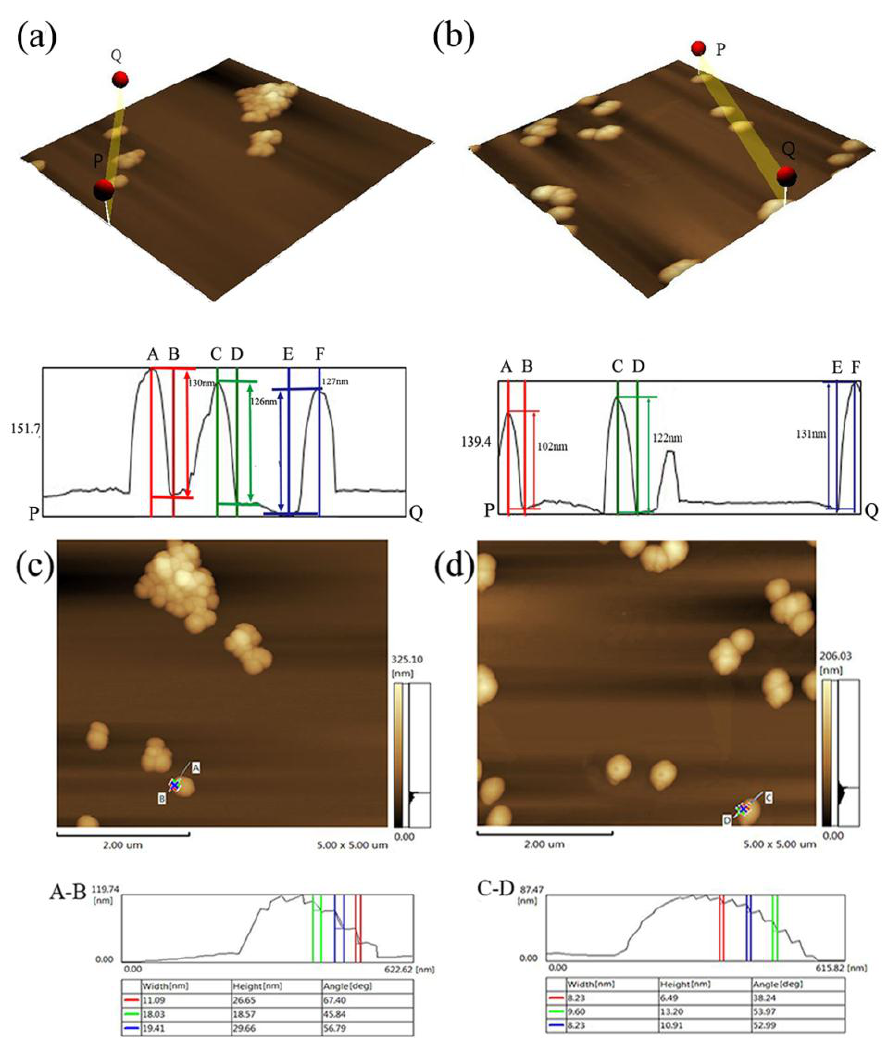
Figure 3. SPM 5 µ m × 5 µ m images of O -Fe 3 O 4 /FePc (( a ) 3D and ( c ) 2D) and E -Fe 3 O 4 /FePc (( b ) 3-D and ( d ) 2-D).